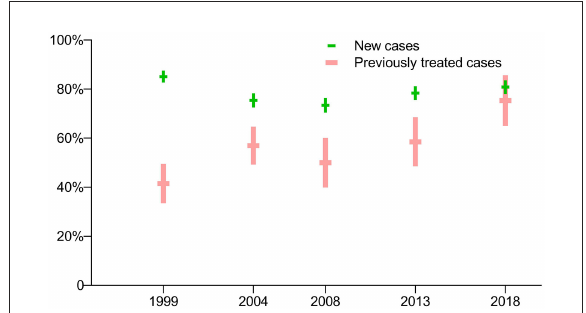
FIGURE1 Prevalence of TB cases susceptible to all four first-line anti-TB drugs: breakdown by treatment history in five periodic surveys.